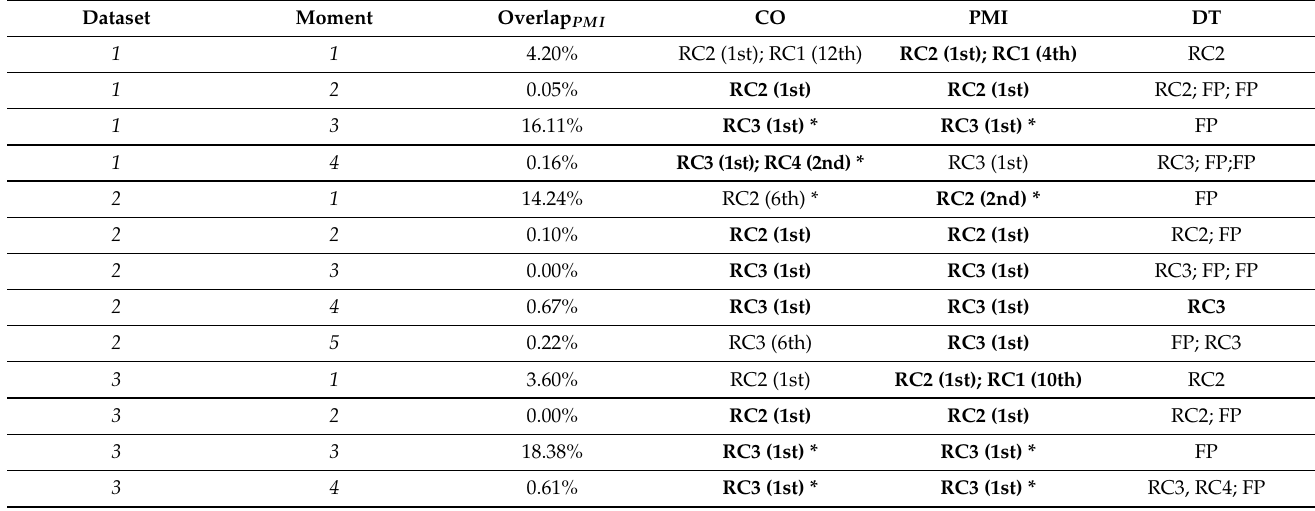
Table 5. Table with the results of the RCA algorithms (FP—False